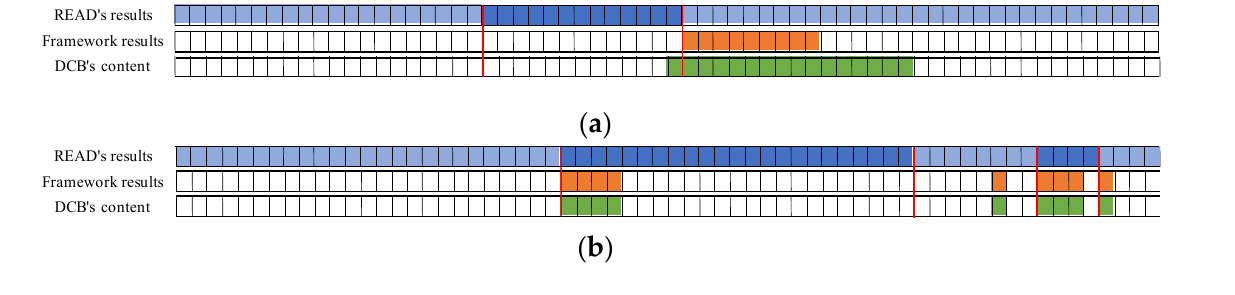
Figure 19. Boundary division results of bit-flip rate and proposed method: ( a ) Continuous value division result (0x082 for steering); ( b ) Discrete value division result (0x228 for gear).